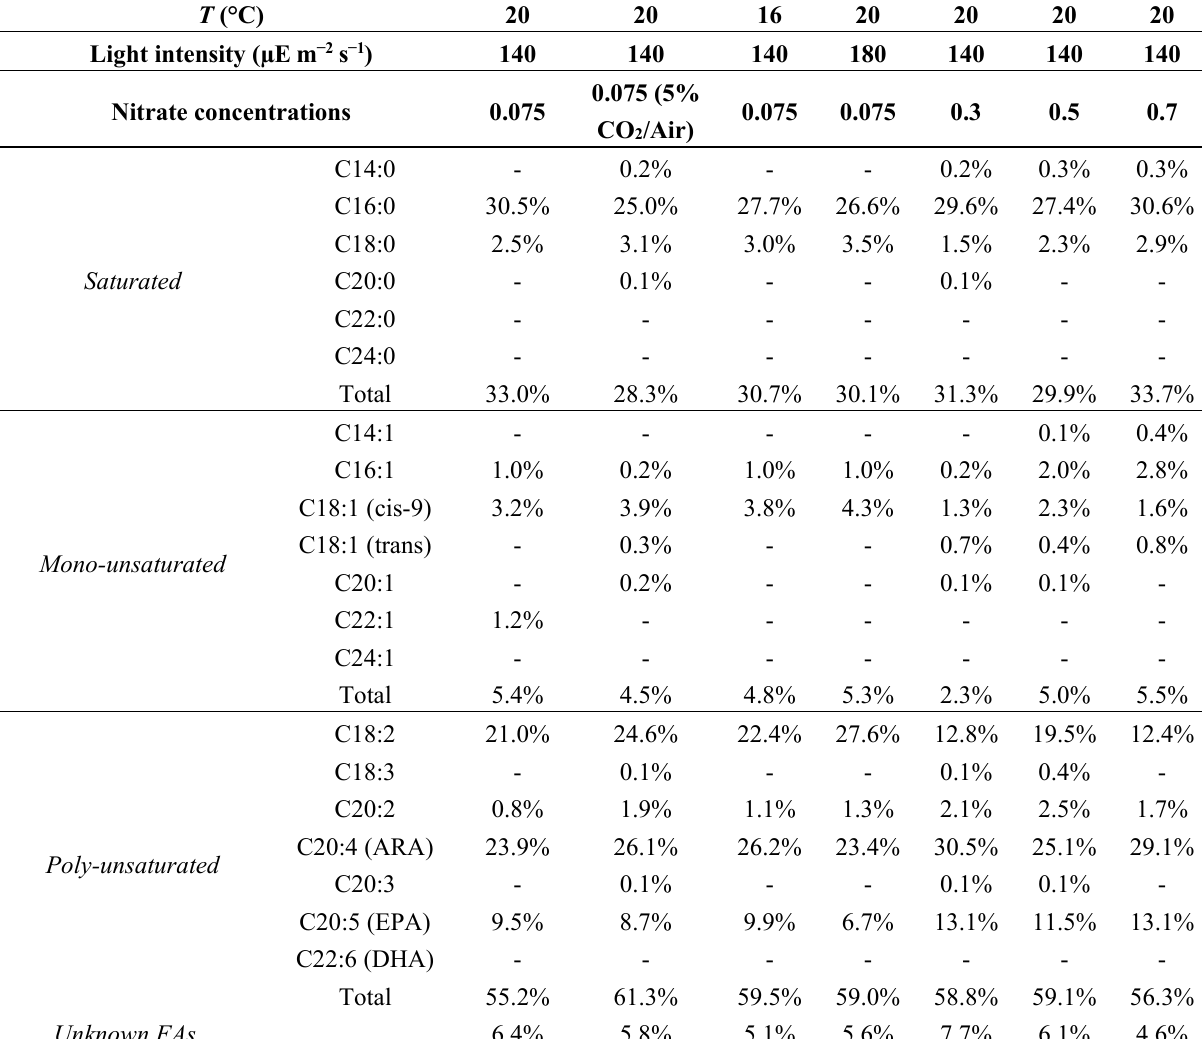
Table 1. Fatty acid compositions of P. cruentum strain (% of total fatty